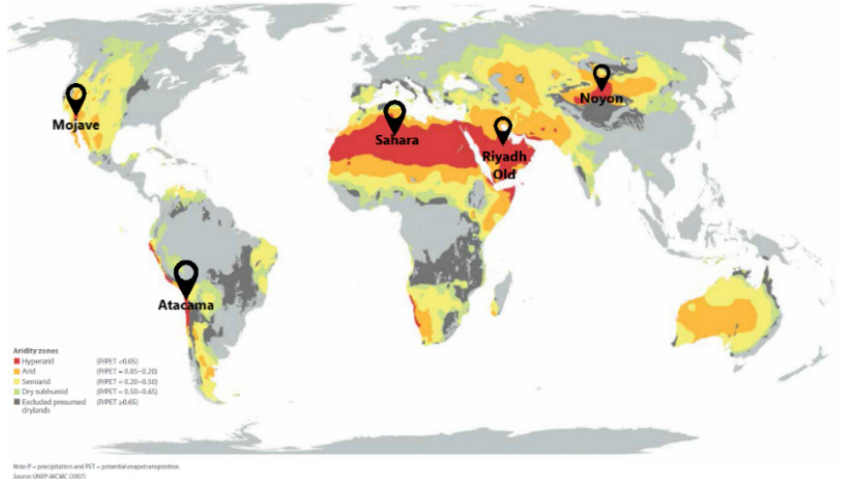
Figure 7. Selected reference regions with extremely arid climates [47]. Table 1. Climatic data for the selected